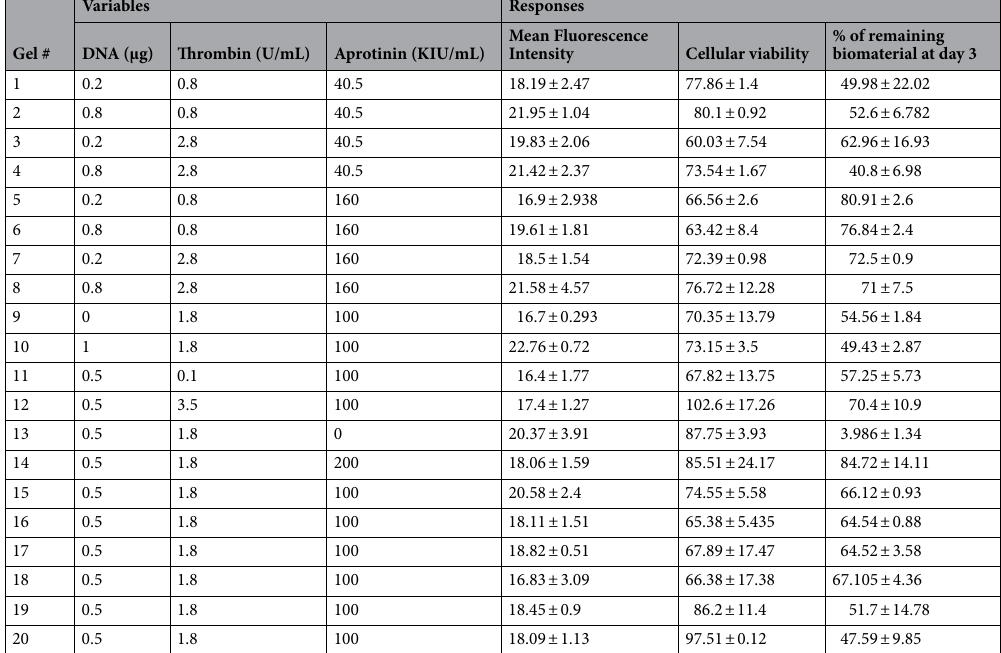
Table 2. Characterisation of fibrin gels through design of experiment. A response surface design was used to determine whether aprotinin, thrombin or DNA affected transfection efficiency, cellular viability and biomaterial stability. Results are representative of three independent experiments, with N =